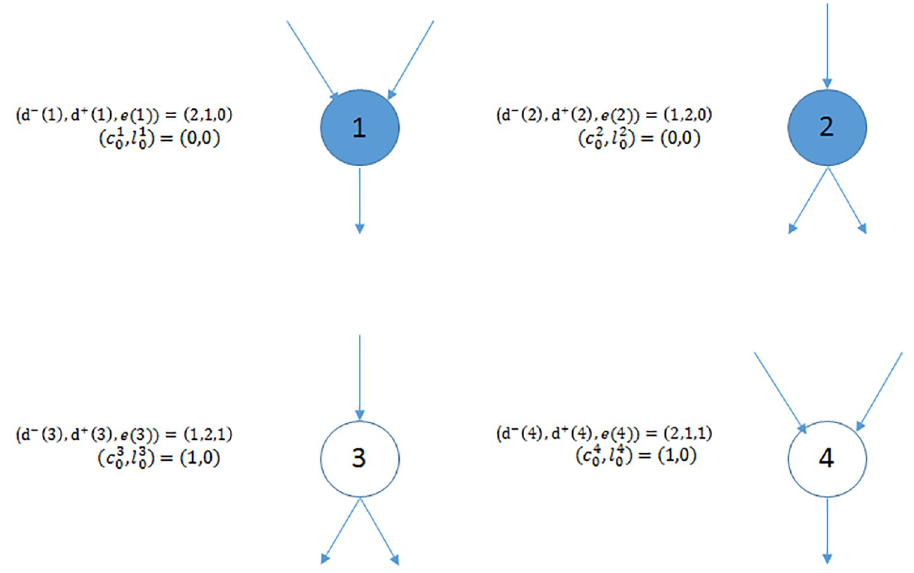
Fig 2. Financial network before default contagion occurs. ( d − ( v ), d + ( v )) are the degrees and e ( v ) is the initial equity of node v . The nodes in the initial default set D ¼ f 1 ; 2 g are marked in blue. 0